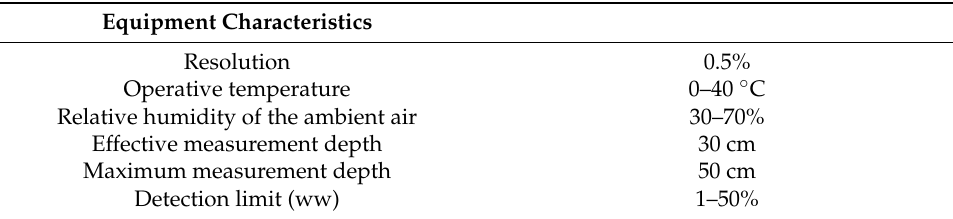
Table 1. EMCO ® model AP 500-M3 operational characteristics, according to the manufacturer.